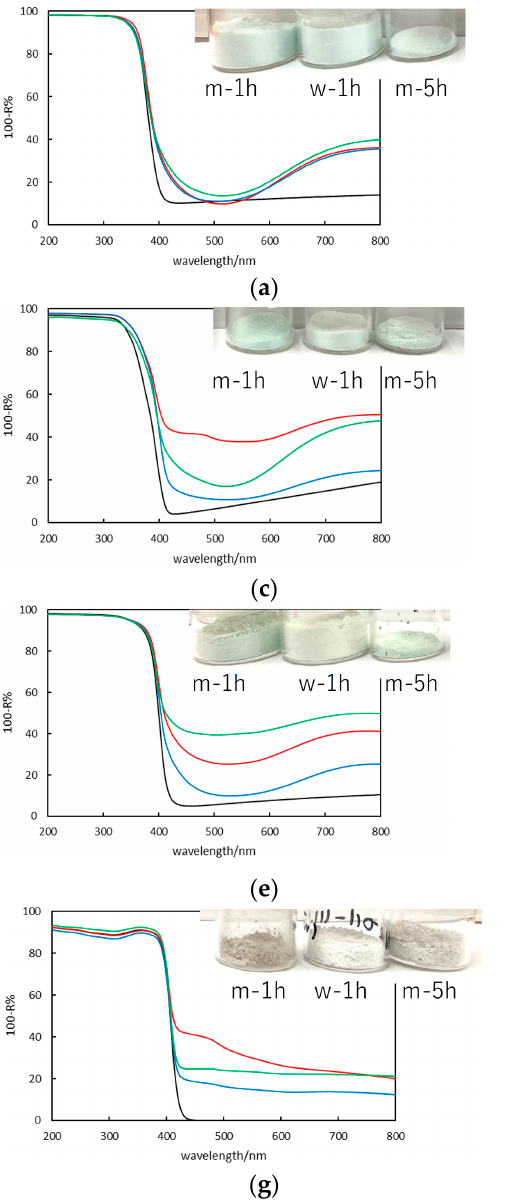
Figure 2. Diffuse reflectance (DR) spectra with respective photographs of copper-modified titania (with diffuse reflectance spectroscopy (DRS) for bare titania as reference): ( a ) ST-01, ( b ) FP6, ( c ) P25, ( d ) ST-41, ( e ) TIO-6, ( f ) ST-G1 and ( g ) TIO-5 (black: bare, red: m-1h, blue: w-1h, green: m-5h).